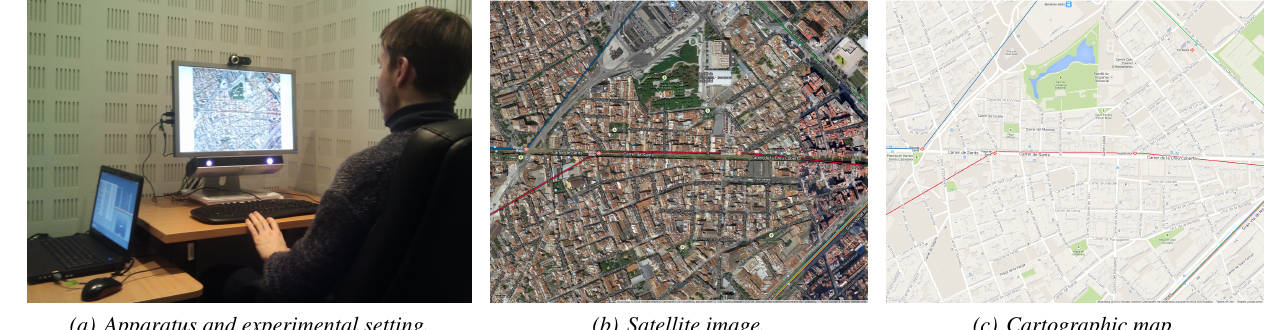
Figure 1 . Experimental settings and (Barcelona) stimuli: satellite image and cartographic